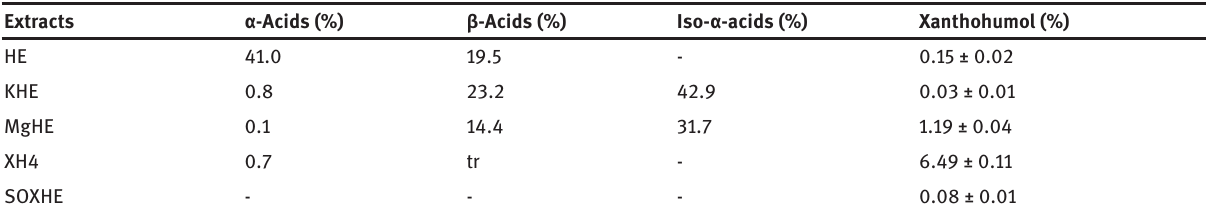
Table 2: The percentage content of α-acids, β-acids, iso-α-acids and xanthohumol achieved by HPLC in the investigated hops extracts: supercritical carbon dioxide extract (HE), extract obtained from HE by isomerization with potassium salts (KHE), extract obtained from HE by isomerization with magnesium oxide (MgHE) and extract obtained after SCO